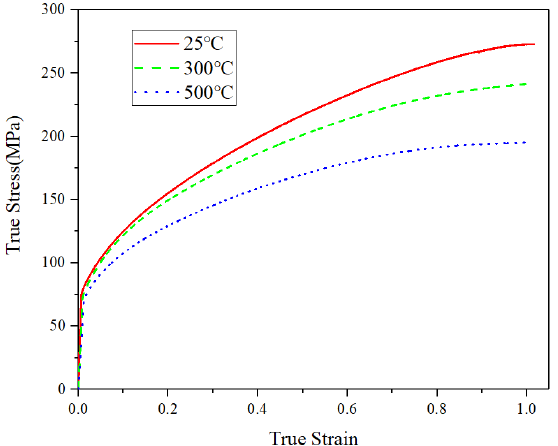
Figure 7. The compressive stress–strain curve of the copper block at different temperatures.